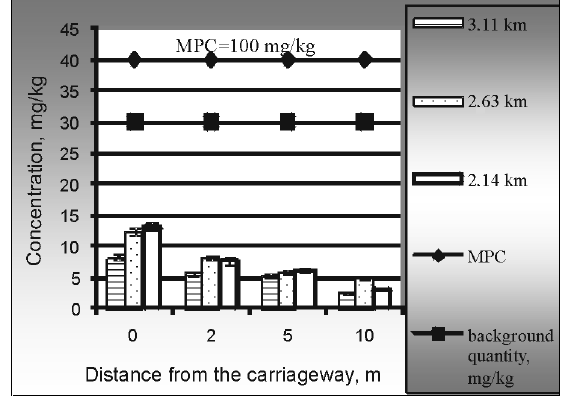
Fig. 12. Chromium concentration in the roadside soil of the gravel road Šeiniūnai – Vindeikiai – Uliškiai concentration of Cr determined in these roadsides, and 12 times below the background quantity. In the second sam- pling section Cr concentration right next to road